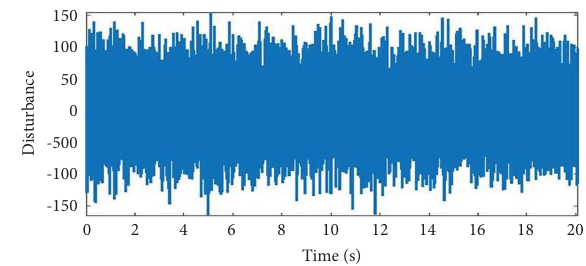
Figure 5: Te stochastic disturbance.